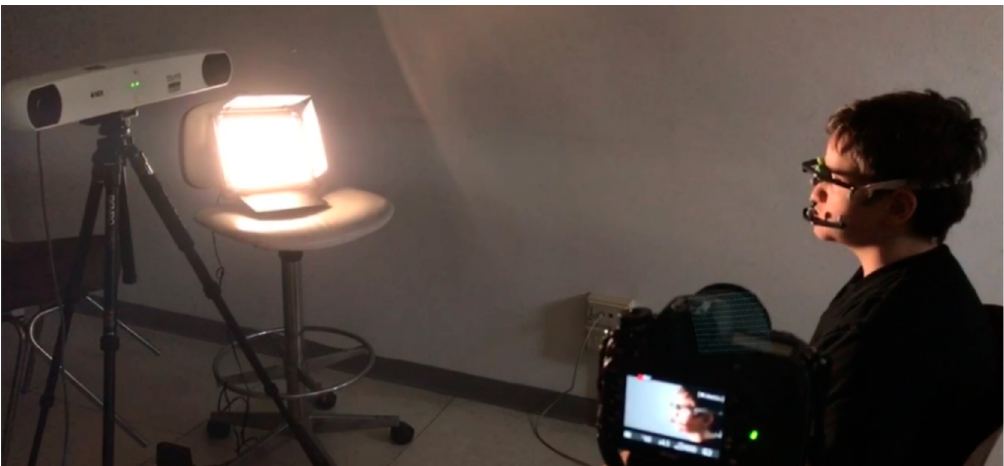
Figure 3. Acquisition set-up. The volunteer is sitting straight facing the cameras with the head in a neutral position and he is wearing the cranial and mandibular marker supports.